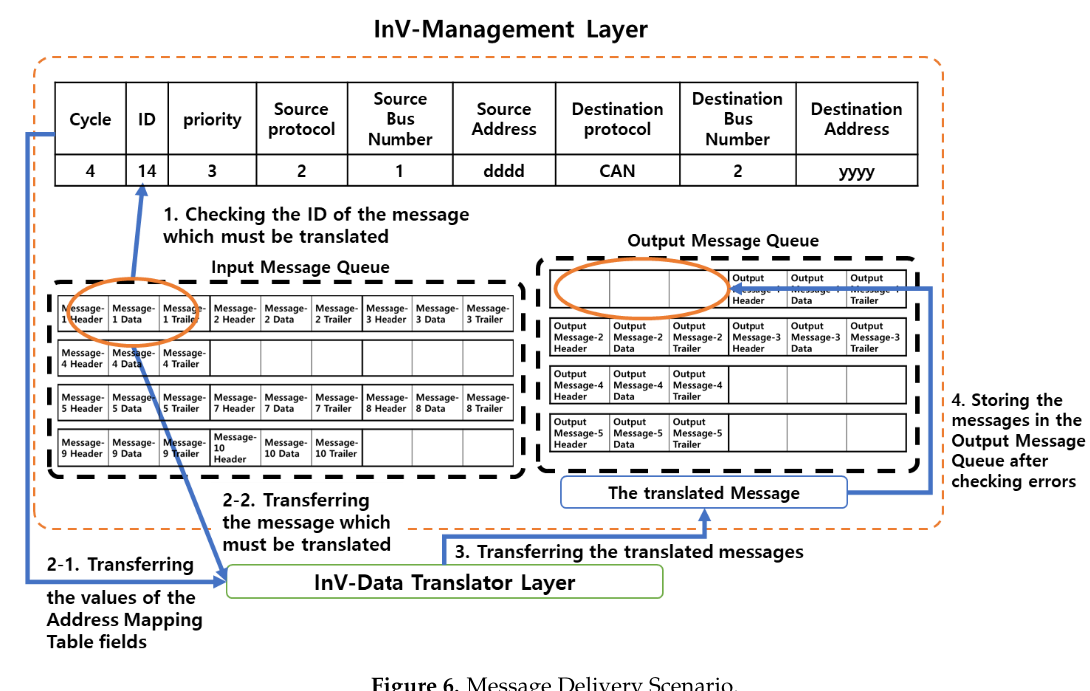
Figure 6. Message Delivery Scenario.